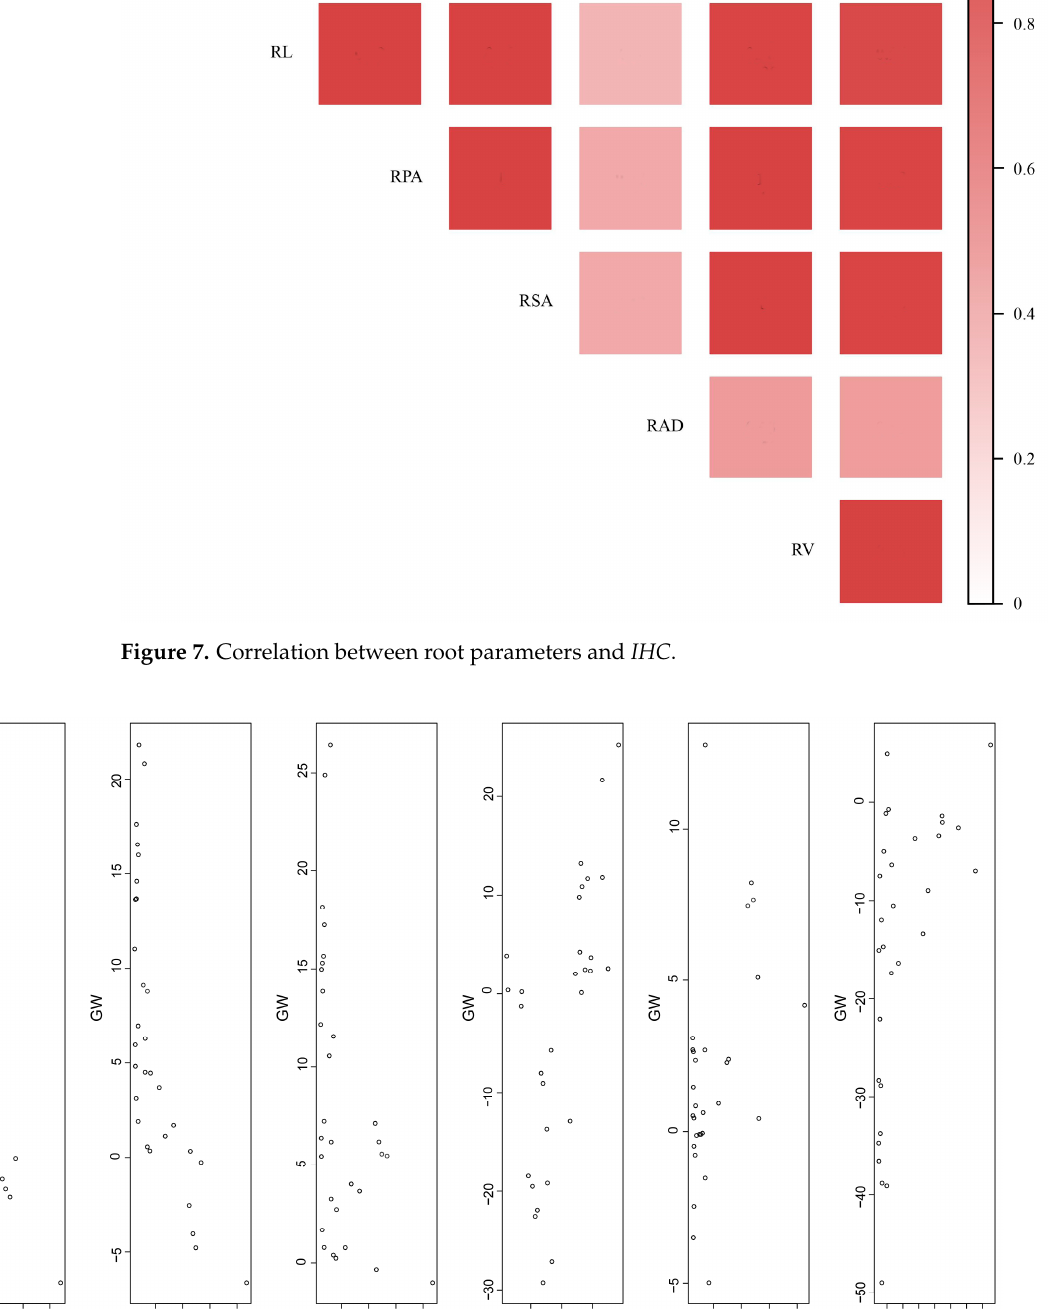
Table 4. Analysis of the correlation between the IHC and root systems with different diameters. Site